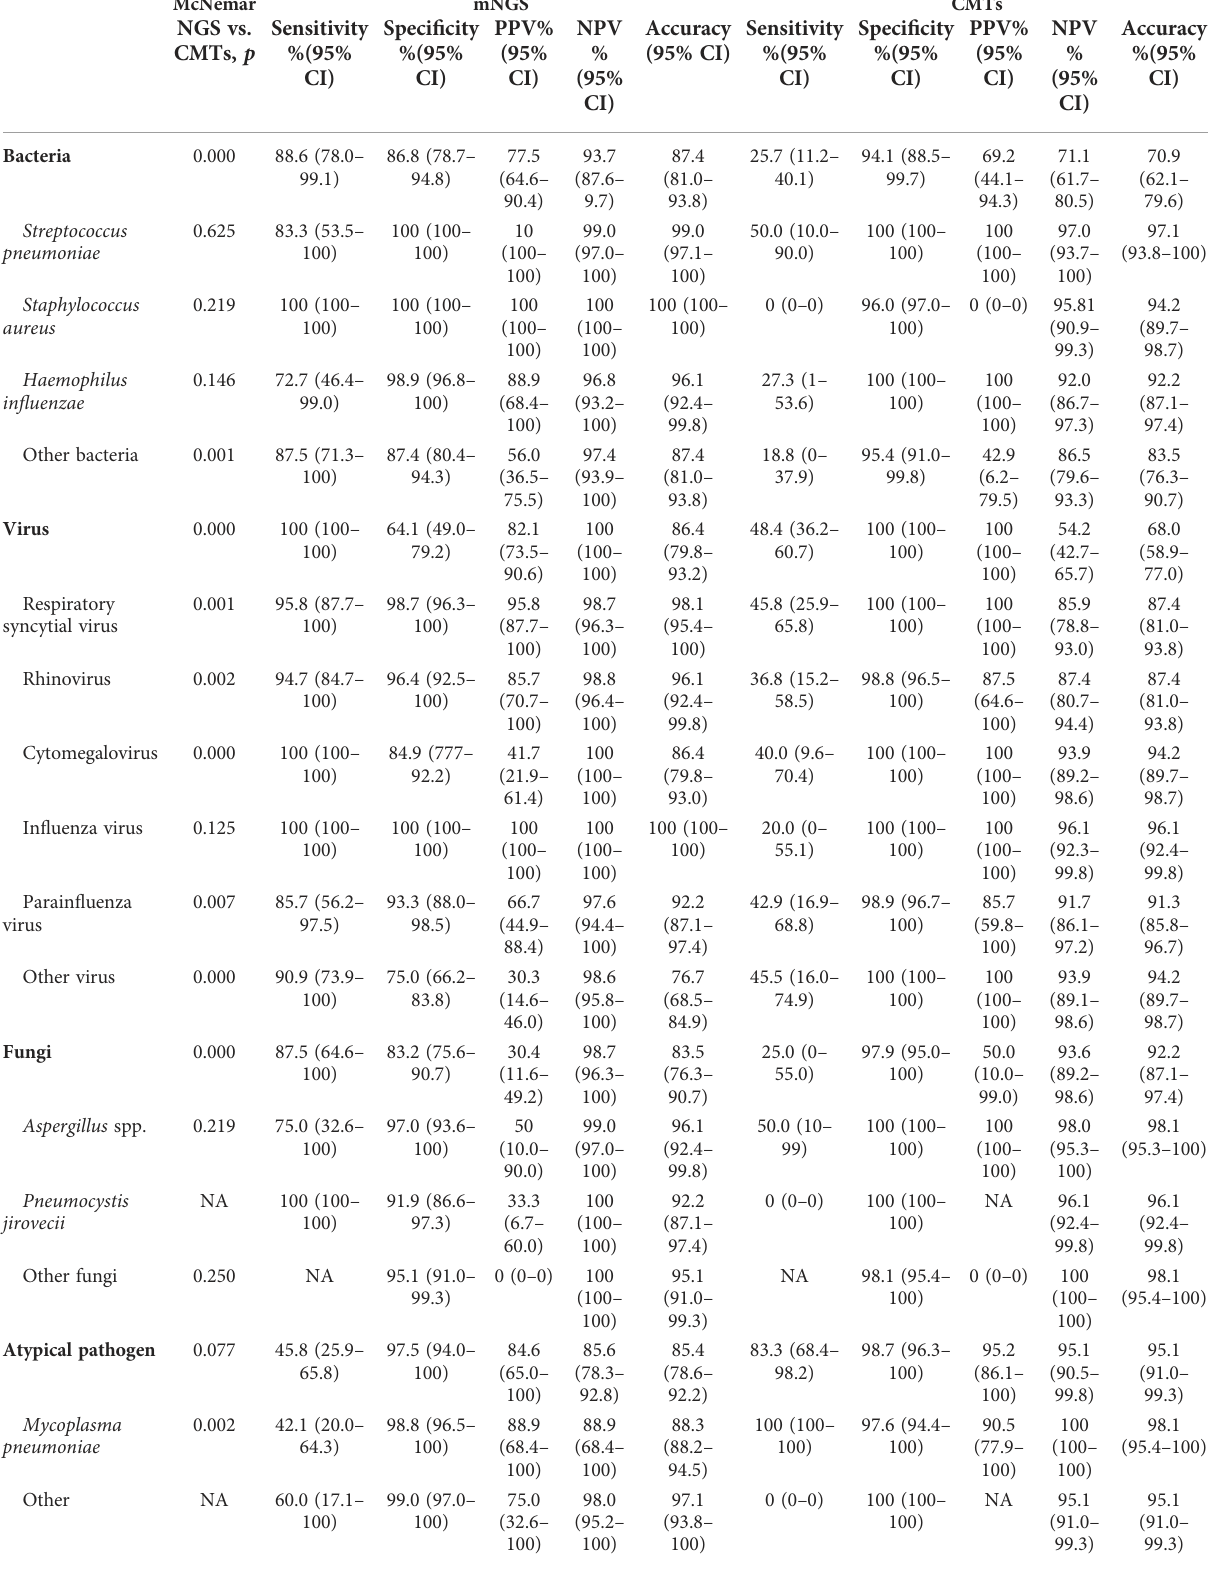
TABLE 3 Comparison of diagnostic performance of mNGS and